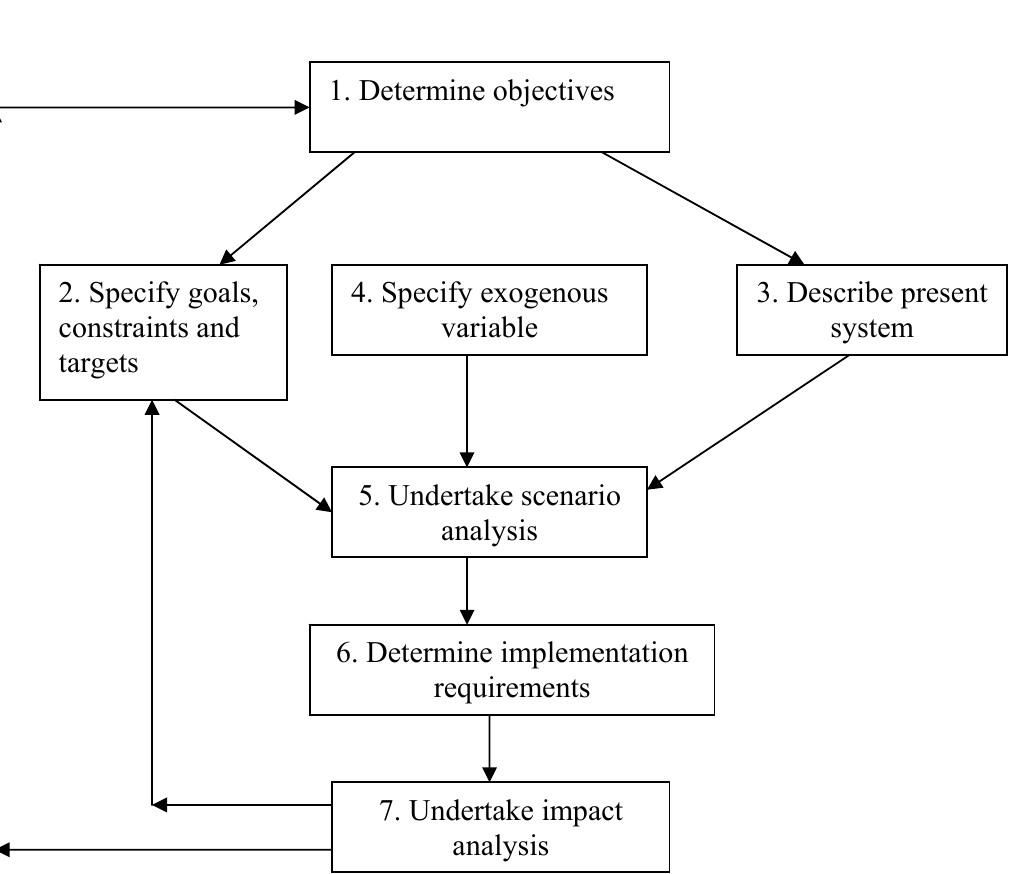
Figure 1. Outline of a general backcasting method (Source: adapted from Robinson,